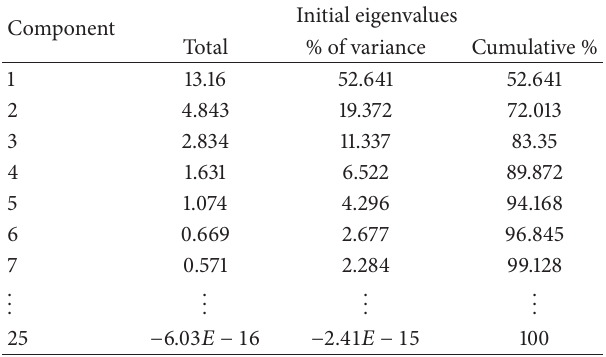
Table 5: Initial eigenvalues of principal